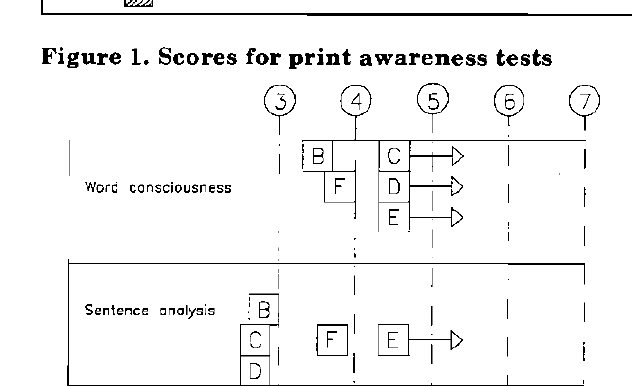
Figure 1. Scores for print awareness tests